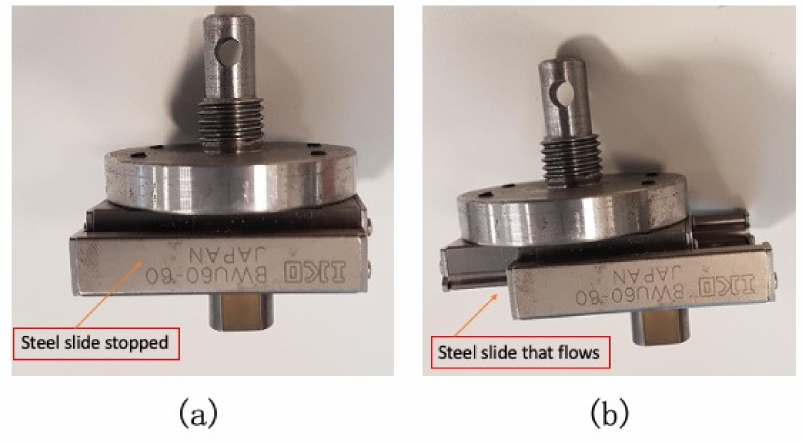
Figure 2. ( a ) The steel slide (BWU60-60, Iko, Japan) that allowed the displacement of the device during the 5-cycles test; ( b ) the steel sliding, allowing the 10 mm displacement of the device at 0.2